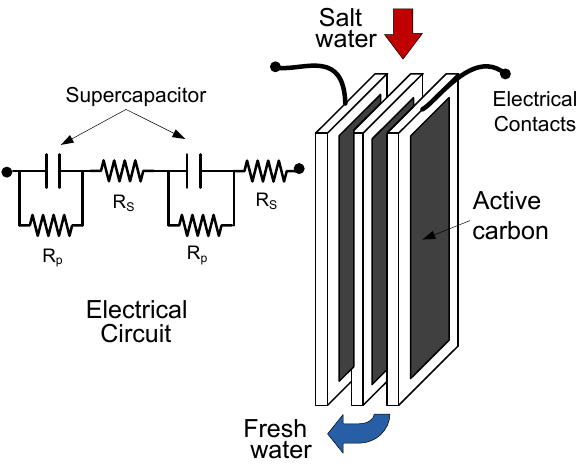
Figure 2. Piling of substrates with screen printed active